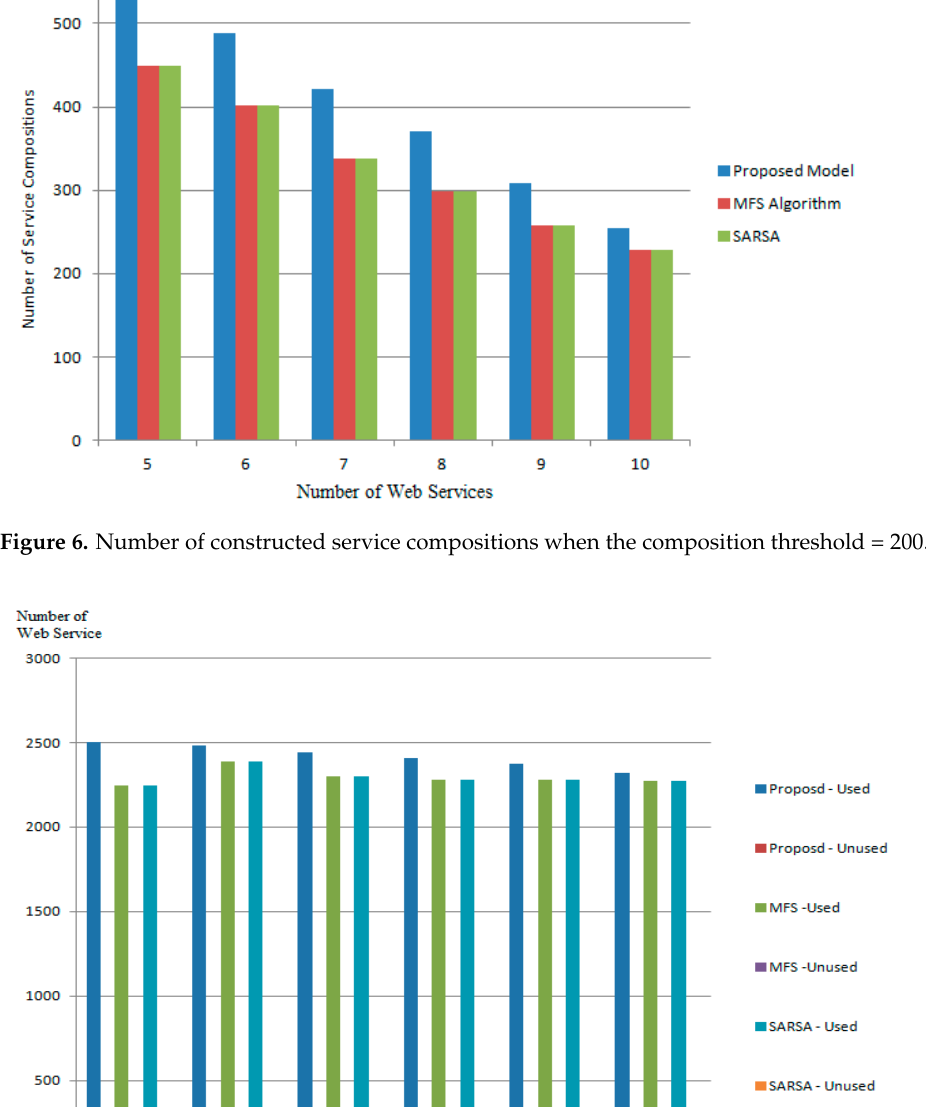
Figure 7. The number of used and the unused web services when the composition threshold = 100.